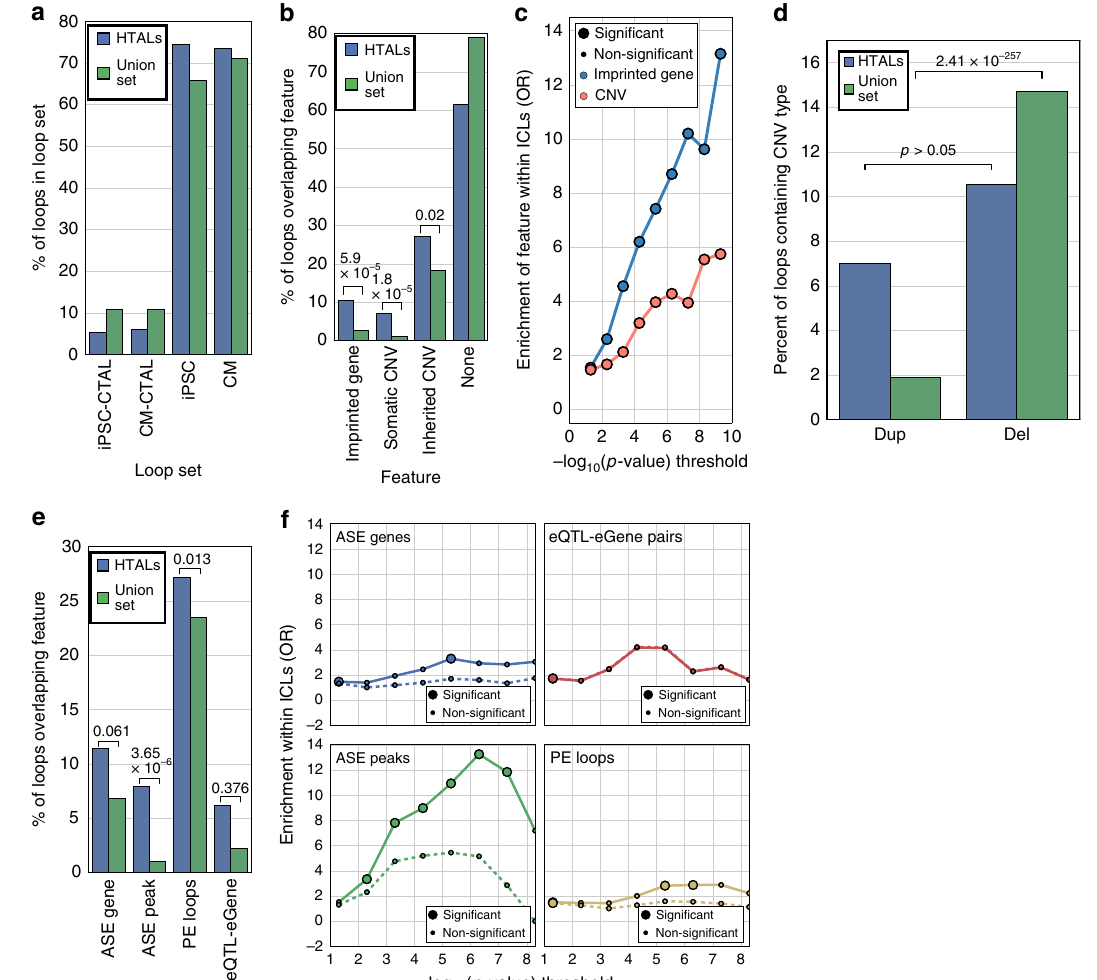
Fig. 6 Functional characterization of haplotypic differences in chromatin conformation. a Barplot showing the percent of union loops (green) or HTALs (blue) contained within each loop set. b Barplot showing the percent of union loops (green) or HTALs (blue) containing the given genomic feature within it (i.e., the genomic feature overlapped the region between the start of the fi rst anchor and the end of the second anchor). P -values were calculated using via a Fisher ’ s exact test. c Line plot showing odds ratio from a Fisher ’ s exact test for HTAL enrichment above the union set for containing an imprinted gene (blue) or containing either an inherited or somatic CNV (red) as a function of the – log 10 of the HTAL imbalance p -value. Large circles indicate that the test was signi fi cant after Bonferroni correction, and small circles indicate a non-signi fi cant association. d Barplot showing the percentage of union loops (green) or HTALs (blue) containing only deletions or only duplications. P -values were calculated using a binomial approximation to a normal distribution, adjusted for the number of identi fi ed CNVs which were deletions vs duplications. e Barplot showing the percent of union loops (green) or HTALs (blue) overlapping the given genomic feature at an anchor. P -values were calculated using a Fisher ’ s exact test. f Line plot showing odds ratio from a Fisher ’ s exact test for HTAL enrichment above the union set for containing the labeled feature as a function of the – log 10 of the HTAL imbalance p -value, for either all loops (solid lines), or loops that do not contain an imprinted gene or CNV (dashed lines). Large circles indicate that the test was signi fi cant after Bonferroni correction, and small circles indicate a non-signi fi cant